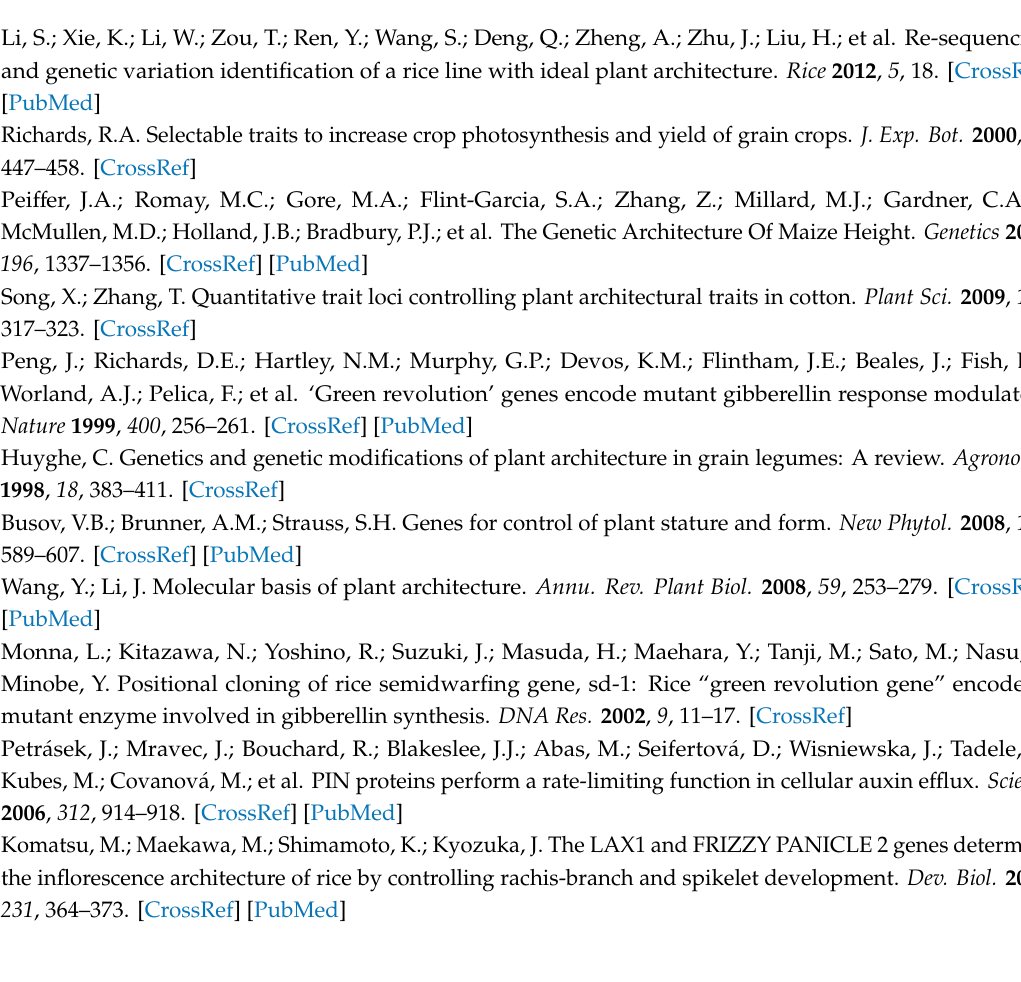
Table S1: The average TPC values of four varieties in continuous three years. Table S2: The correlations analysis of plant architecture in B. napus . Table S3: Di ff erentially expressed genes in high-TPC lines compared to low-TPC lines. Table S4: Di ff erentially expressed genes between two sites in all sequenced samples, Table S5: Enriched GO terms of DEGs in the flower bud. Table S6: Enriched GO terms of common DEGs in the stem apex. Table S7: Enriched KEGG pathway of DEGs in the flower bud. Table S8: Enriched KEGG pathway of DEGs in the stem apex. Table S9: Di ff erentially expressed miRNAs in the stem apex and flower bud. Table S10: Novel miRNAs detected in the high- and low-TPC lines. Table S11: Result comparison of RNA-Seq and qRT-PCR for randomly selected genes. Table S12: qRT-PCR primers used for validation of expression pattern of selected genes. Table S13: Result comparison of sRNA-Seq and qRT-PCR for randomly selected miRNAs. Table S14: qRT-PCR primers used for validation of expression pattern of selected